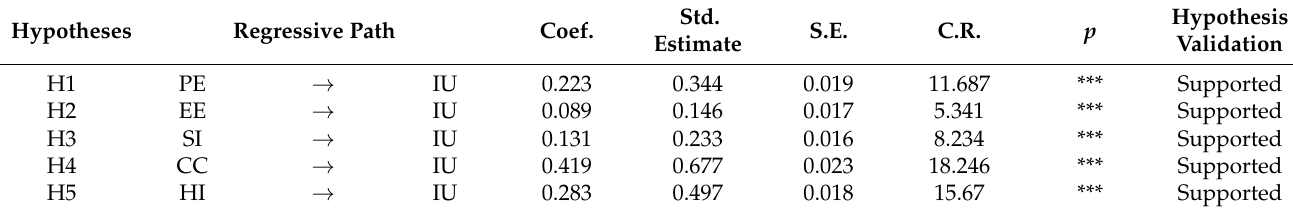
Table 8. Results of structural equation modeling.